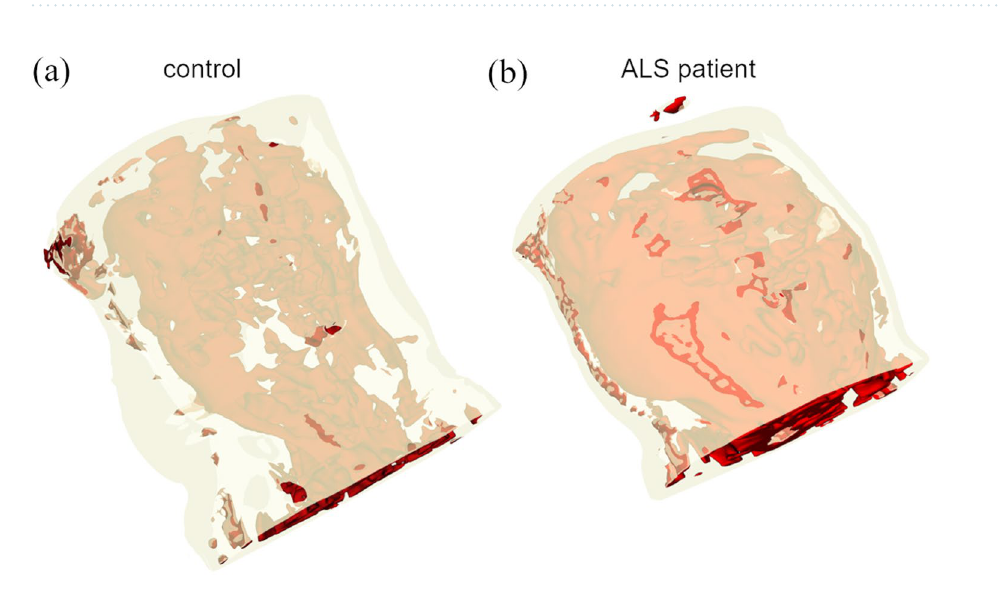
Figure 3. 3D rendering of multi-slice predictions from a control ( a ) and ALS patient ( b